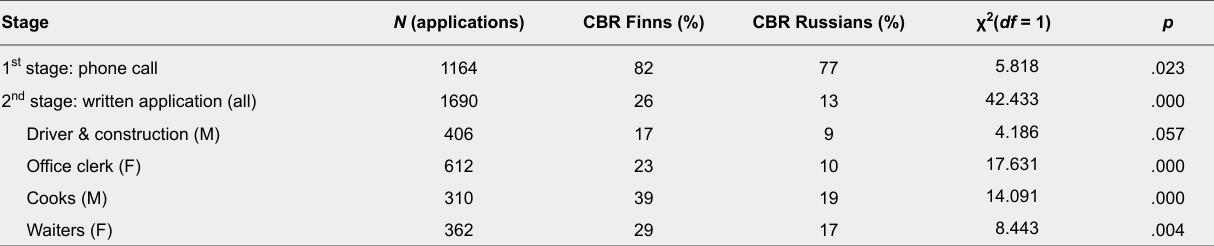
Ethnic Discrimination: Call-Back Rates (CBR) in the 1st and 2nd